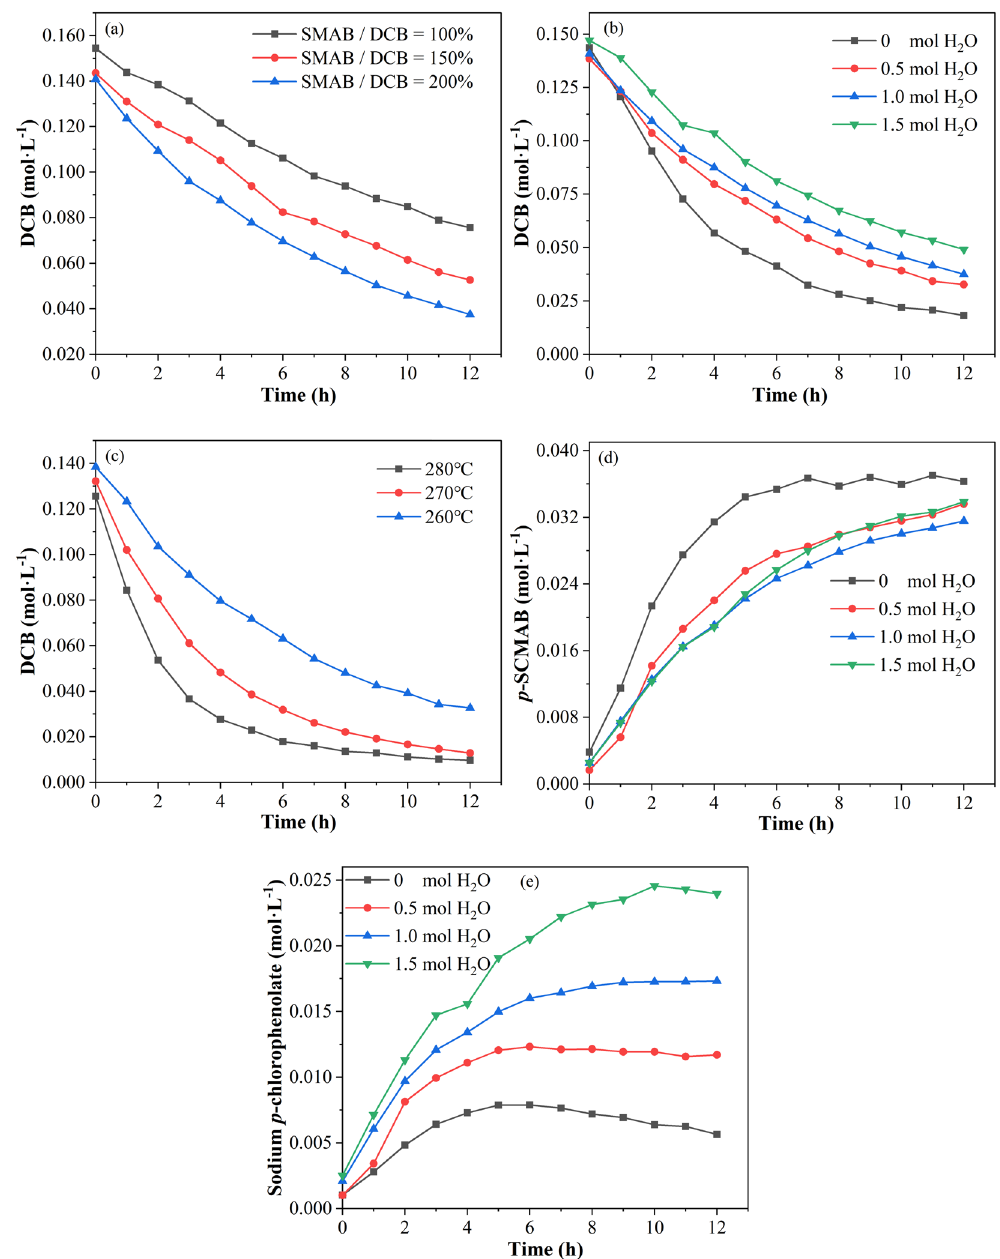
Figure 5: The e ff ects of ( a ) the ratio of SMAB to DCB, ( b ) water content, and ( c ) reaction temperature on the conversion of DCB; ( d ) the solvation e ff ect of water is signi fi cant; ( e ) water is favorable to the formation of sodium p -